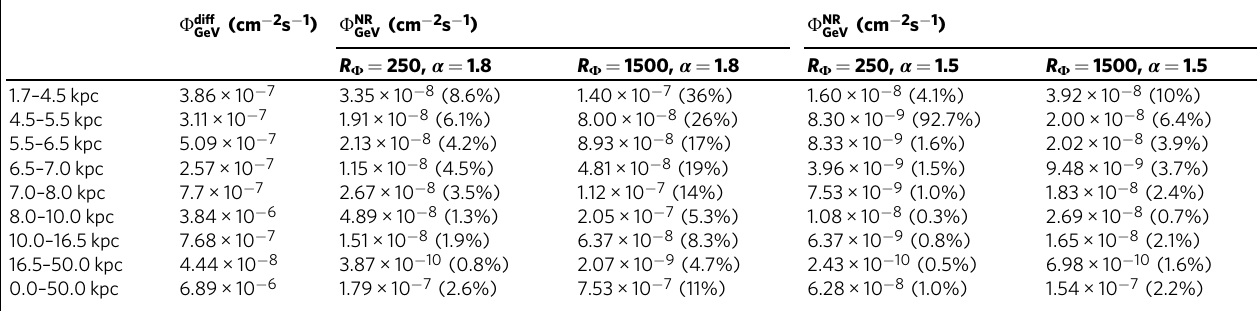
Table 1 The cumulative gamma fl uxes due to unresolved Pulsar Wind